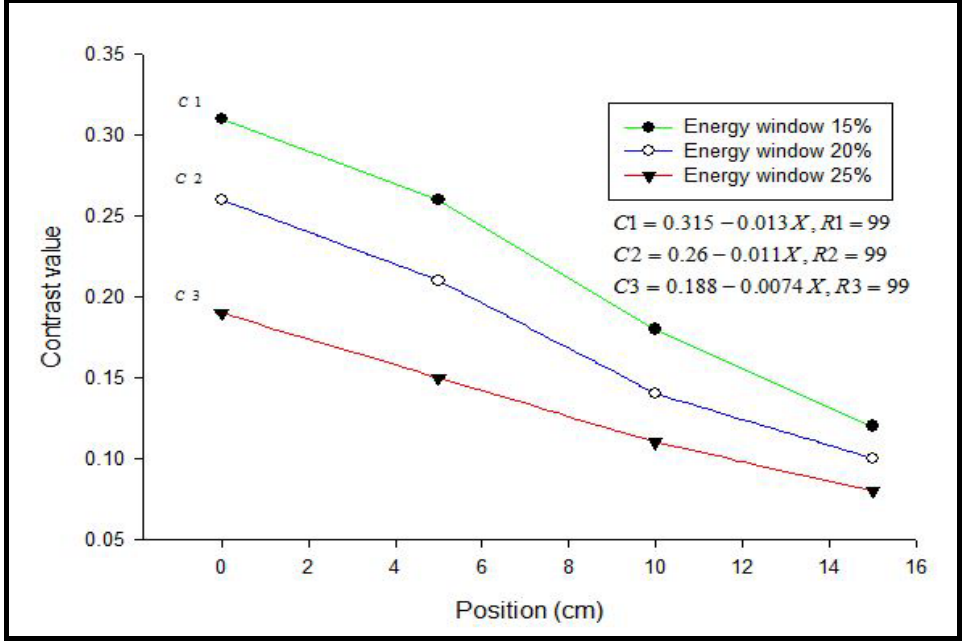
Figure 6. Effect of the positioning on defect contrast in the anterior region of myocardial SPECT image in different energy windows.